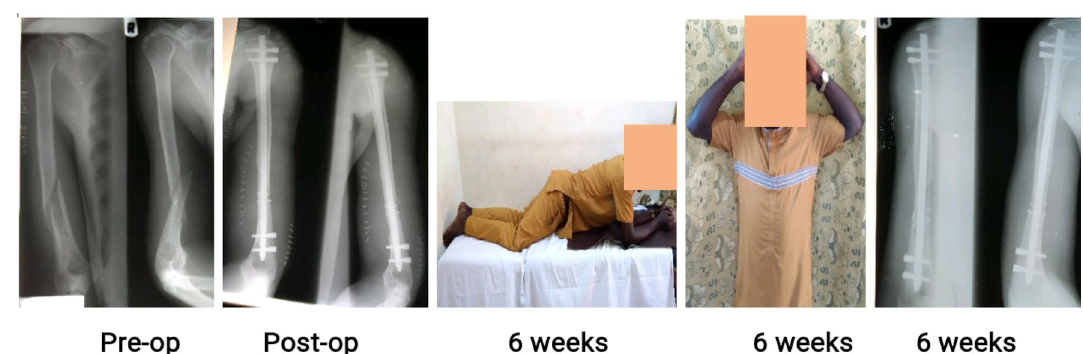
Figure 3. A 35-year old factory worker with atrophic non-union of a 12-A1 fracture nailed 3.52 months post- injury. He was back at work before the 6-week follow-up.